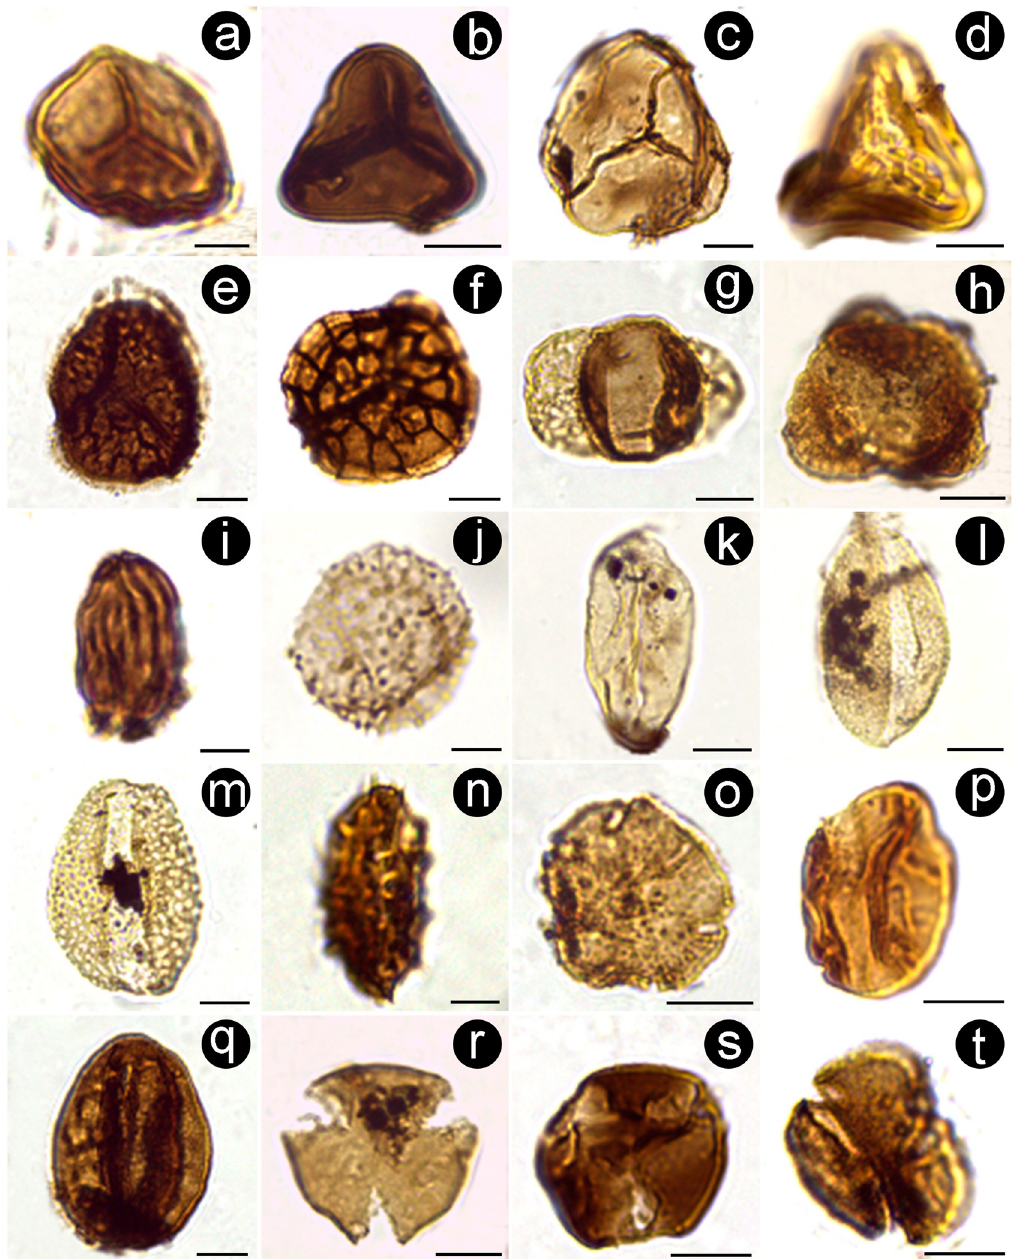
Fig 5. Microscope images of selected spores and pollen grains from the Casa Grande Formation. (A) Todisporites minor (PAL JUA (P) Cz/Plg. N˚ 001c(Eo)+10 μ m: 21.9–150.9). (B) Deltoidospora minor (PAL JUA (P) Cz/Plg. N˚ 001d(Eo)+10 μ m: 10–135). (C) Leiotriletes sp. (PAL JUA (P) Cz/Plg. N˚ 001c(Eo)+10 μ m: 9–138.9). (D) Polypodiaceoisporites cf. P . retirugatus (PAL JUA (P) Cz/Plg. N˚ 001b(Eo)+10 μ m: 21.5–131). (E) Reboulisporites fuegiensis (PAL JUA (P) Cz/Plg. N˚ 001e(Eo)+25 μ m: 3.5–139.4). (F) Zlivisporis sp. (PAL JUA (P) Cz/Plg. N˚ 001f(Eo)+25 μ m: 16–151). (G) Podocarpidites sp. (PAL JUA (P) Cz/Plg. N˚ 001b(Eo)+10 μ m: 3–153.5). (H) Microcachryidites antarcticus (PAL JUA (P) Cz/Plg. N˚ 001d(Eo)+10 μ m: 3.9–130.5). (I) Equisetosporites notensis (PAL JUA (P) Cz/Plg. N˚ 001e(Eo)+10 μ m: 4.5–154.6). (J) Smilacipites cf. S . herbaceoides (PAL JUA (P) Cz/Plg. N˚ 001d(Eo)+10 μ m: 16.9–135.5). (K) Arecipites minutiscabratus (PAL JUA (P) Cz/Plg. N˚ 001d(Eo)+10 μ m: 23– 152.2). (L) Liliacidites vermireticulatus (PAL JUA (P) Cz/Plg. N˚ 001d(Eo)+10 μ m: 24.2–126.9). (M) Liliacidites mirus (PAL JUA (P) Cz/Plg. N˚ 001d(Eo)+25 μ m: 15–139). (N) Echimonocolpites sp. (PAL JUA (P) Cz/Plg. N˚ 001b(Eo)+10 μ m: 5.2– 128.9). (O) Nothofagidites anisoechinatus (PAL JUA (P) Cz/Plg. N˚ 001e(Eo)+10 μ m: 13–128). (P) Nothofagidites saraensis (PAL JUA (P) Cz/Plg. N˚ 001e(Eo)+10 μ m: 15.5–152.6). (Q) Retitrescolpites adultus (PAL JUA (P) Cz/Plg. N˚ 001d(Eo)+25 μ m: 14–150.4). (R) Tricolpites asperamarginis (PAL JUA (P) Cz/Plg. N˚ 001d(Eo)+10 μ m: 13.8–128.8). (S) Tricolpites membranus